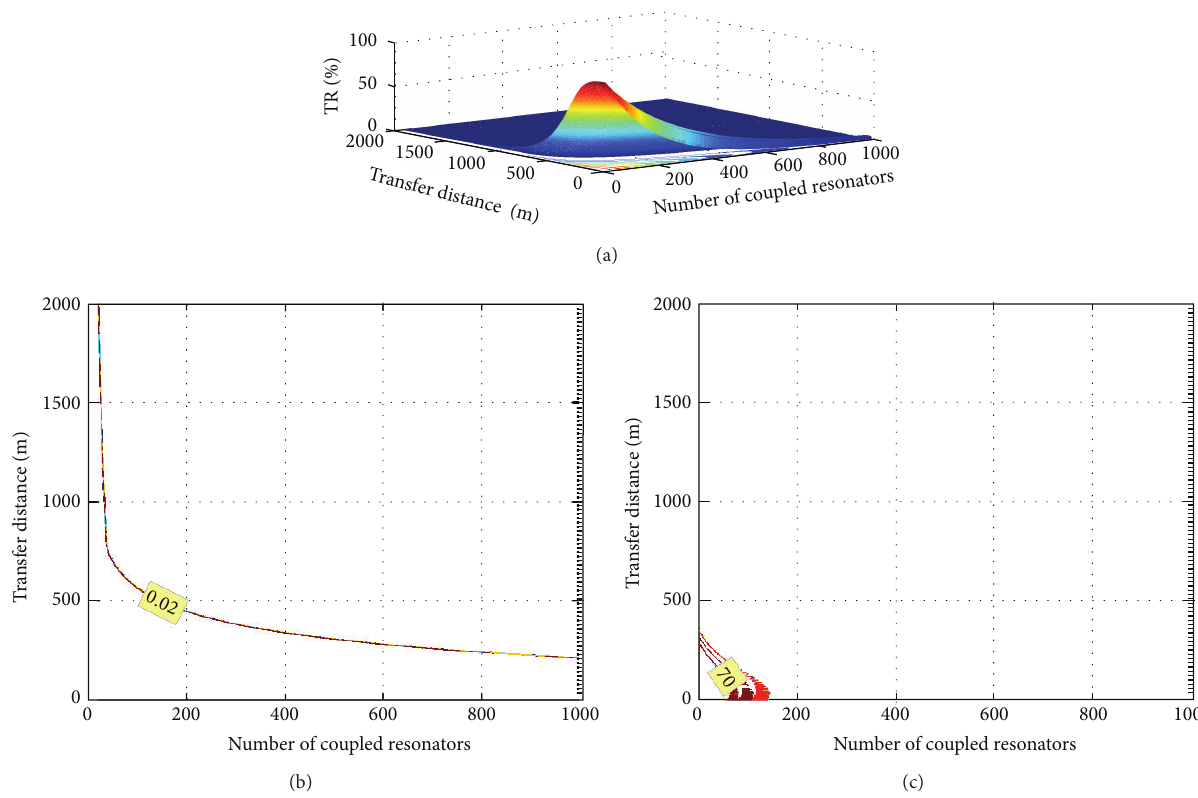
Figure 12: TR versus the number of coupled resonators and transfer distance. (a) Practical DCR configurations. (b) Minimum power transformer TR contour lines. (c) Maximum power transformer TR contour